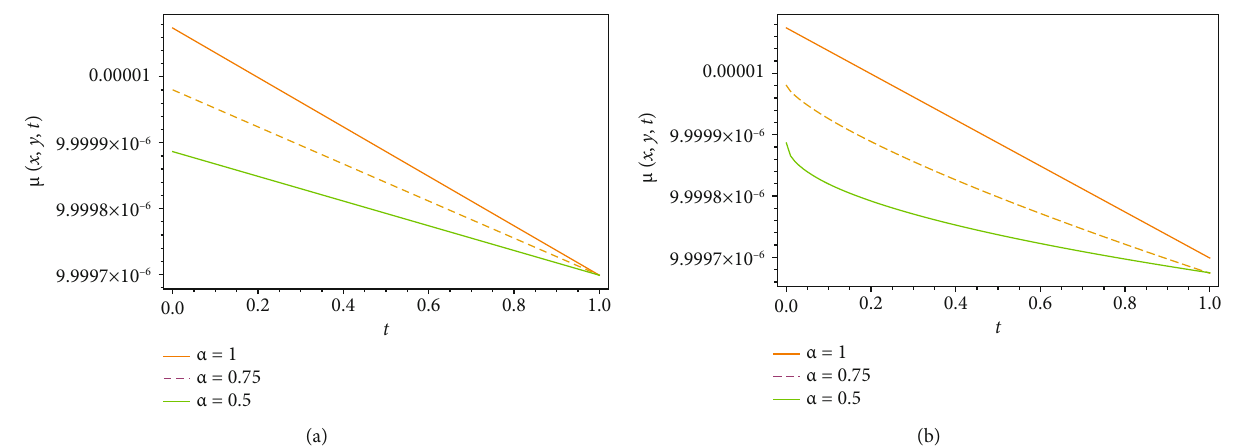
Figure 6: (a) NTDM and (b) NTDM , for x = 0 : 02 , ζ = 0 : 02 , and λ = 0 : 001 for Example 2 with various values of μ CF ABC